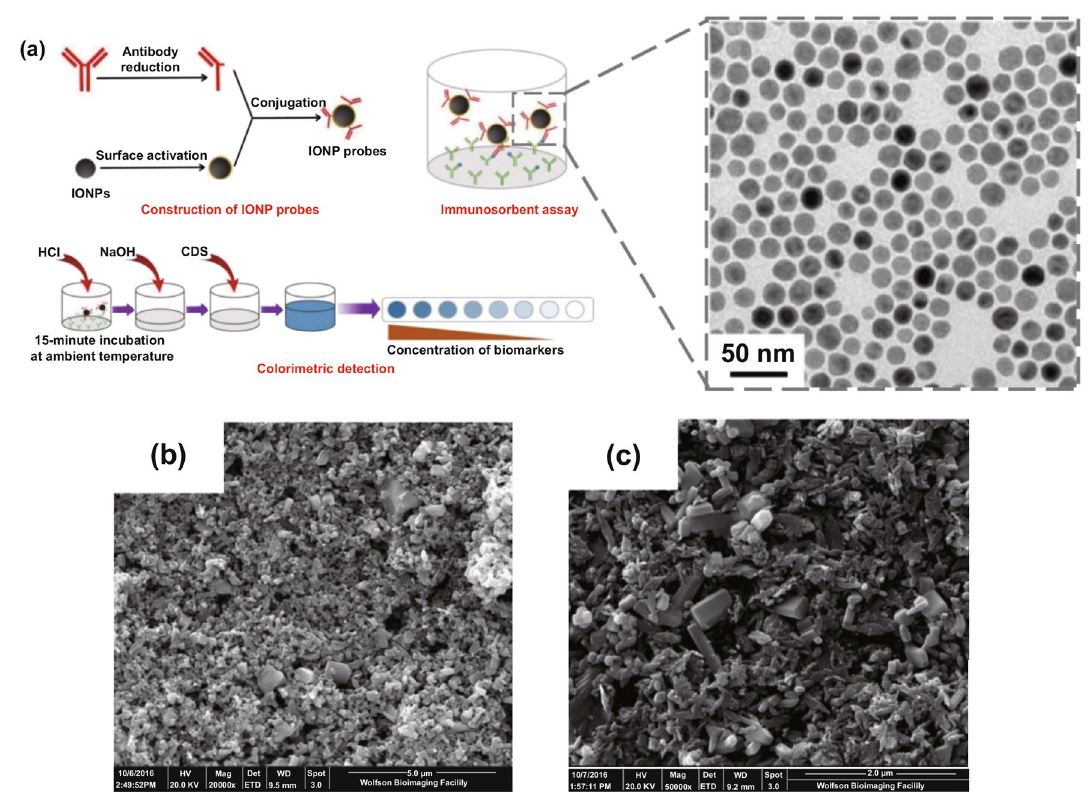
Fig. 6 Nanocrystal-based diagnostic platforms for the detection of CRP. a IONP nanocrystal-linked immunosorbent assay (ILISA): schematic illustration of ILISA protocols for CRP quantification (left) and representative TME image of IONP nanocrystals. Reproduced with permission from Ref. [144]. Copyright 2016 Ivyspring International Publisher. b Representative SEM image of ZnO nanocrystal sensor surfaces on polyeth- ylene terephthalate. Reproduced with permission from Ref. [145]. Copyright 2018 Nature Publishing Group. c Representative SEM image of the ZnO–CuO hybrid nanocrystal sensor surface. Reproduced with permission from Ref. [143]. Copyright 2019